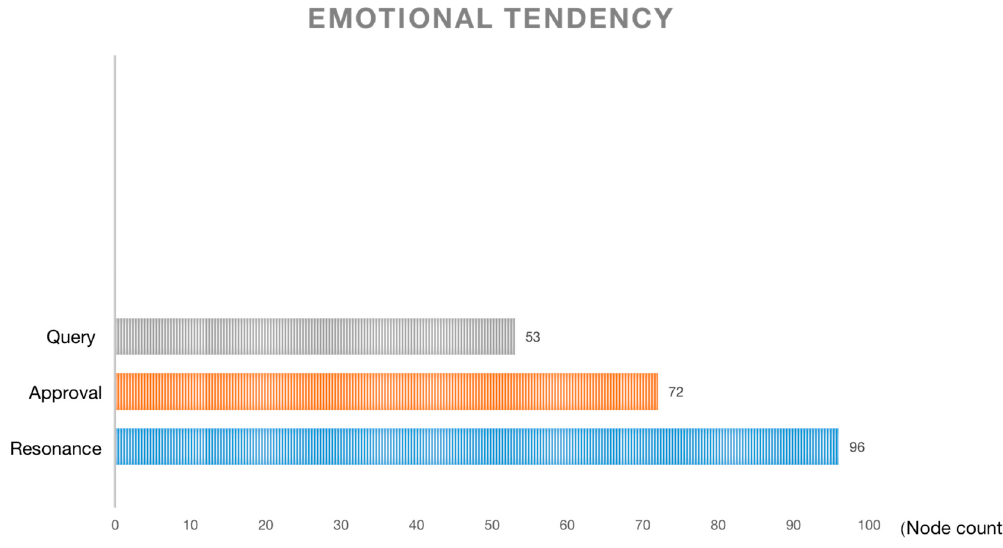
Figure 5. Emotional